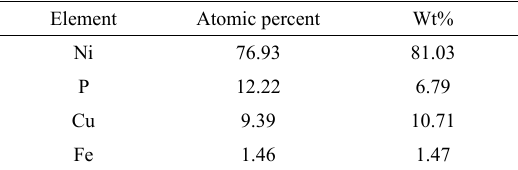
Table 6. The amount of different alloying elements in Ni-P- 3gr/ lit Cu composite coating.